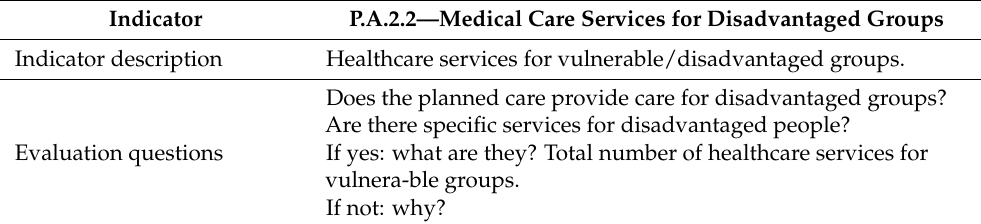
Table 5. The indicator P.A.2.2—Medical care services for disadvantaged groups.